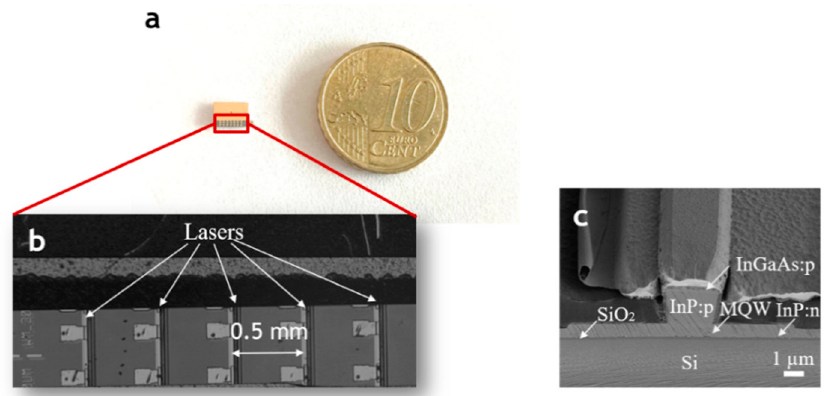
Figure 9. Selectively grown laser array on silicon: ( a ) photograph of the chip mounted on a thermally conductive submount; ( b ) Microscopic image of the laser array; ( c ) Cross-section of a shallow-ridge laser observed by SEM.